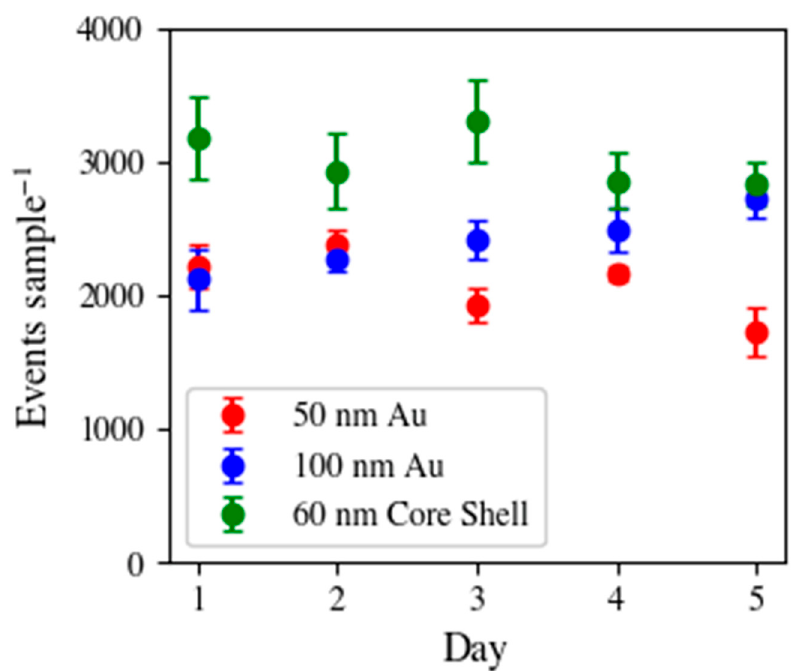
Figure 2. Detection of 50 nm Au (red), 100 nm Au (blue), and 60 nm Au/Ag core-shell (green) NPs presented as the average number of events within the replicate injections [50 nm NPs: n = 10, 100 nm and 60 nm Au/Ag NPs: n = 11] with its respective standard deviation (2 σ ) over the course of 5 days.